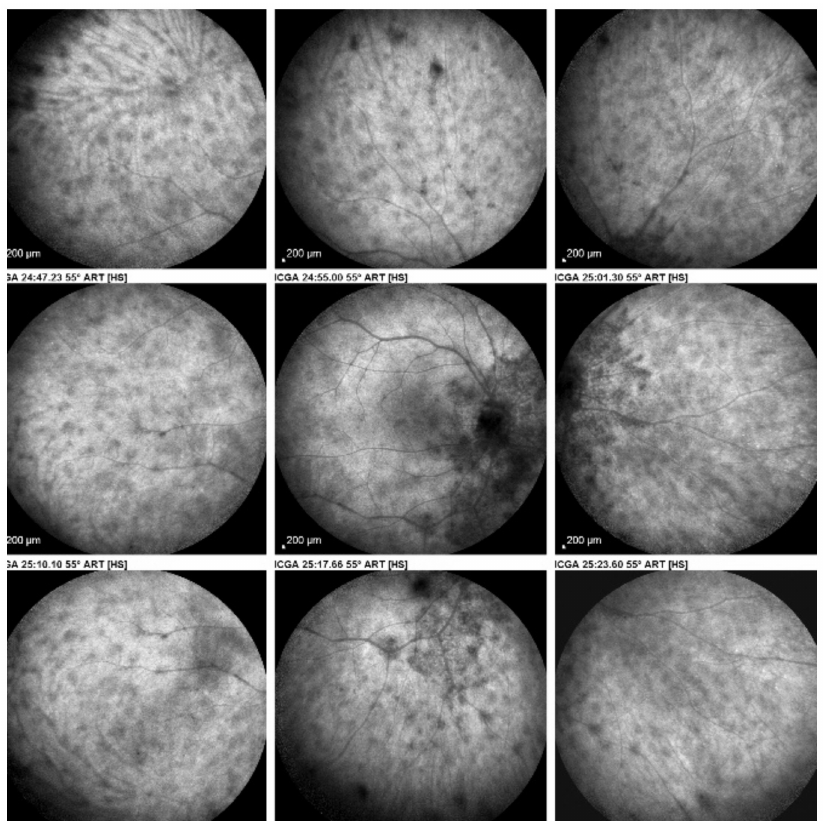
Figure 41. ICGA in BRC. Even round HDDs regularly distributed over all the